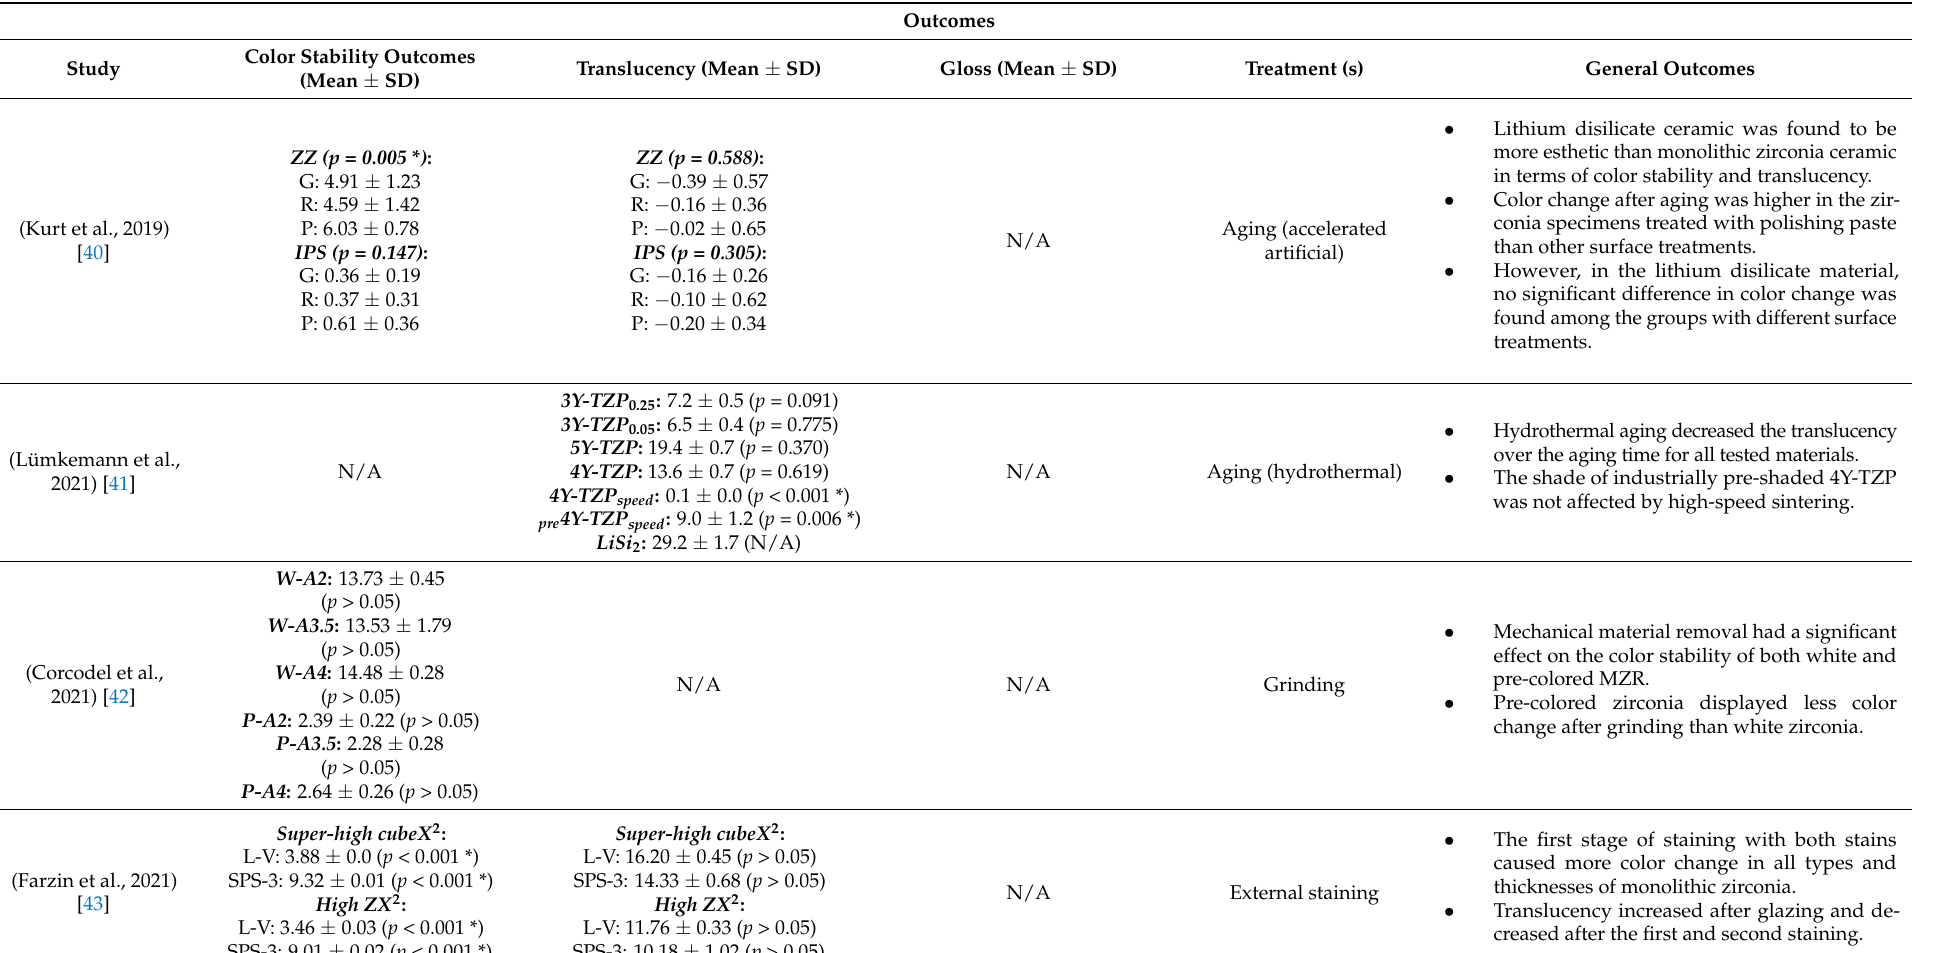
Table 2. Outcomes related to optical properties of the materials assessed in the included